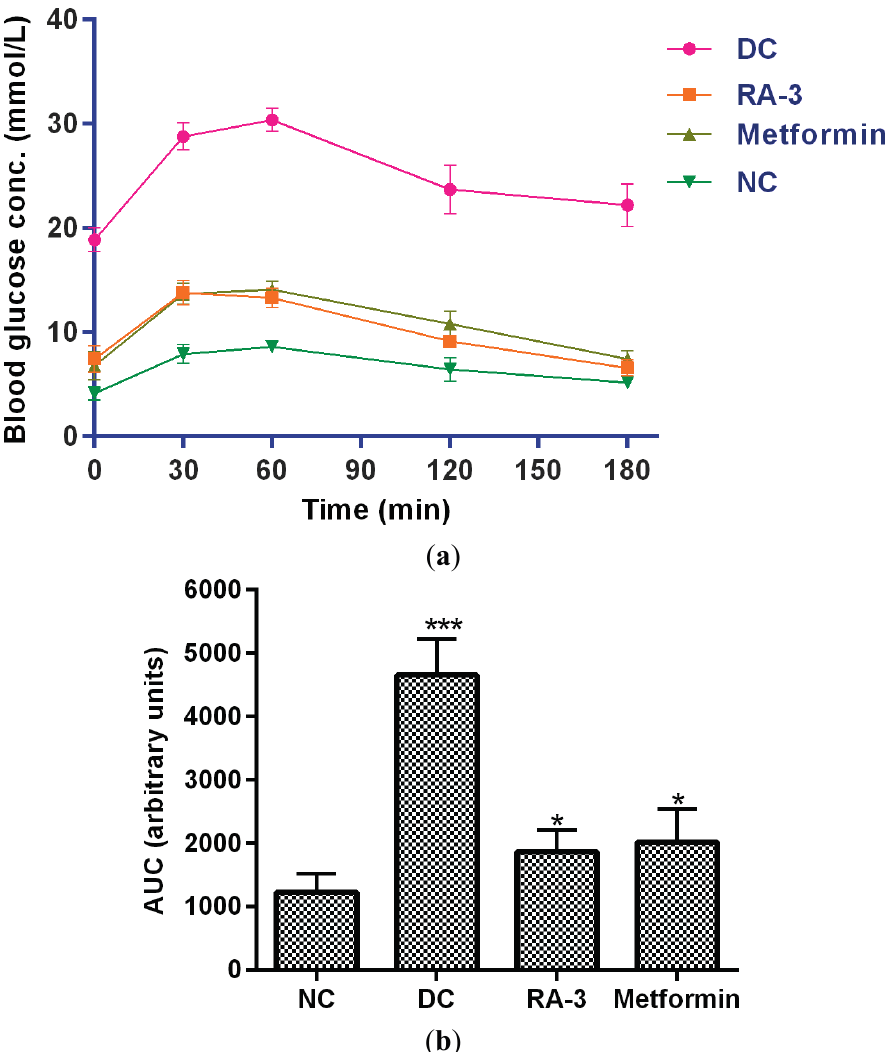
Figure 2. ( a ) Effect of RA-3 on glucose tolerance in diabetic rats. The overnight fasted rats were orally given a glucose load (2 kg/kg b.w). Changes in blood glucose levels were monitored at 0, 30, 60, 90, 120 and 180 min. Data were expressed as mean ± SEM, ( n = 5); NC = Non-diabetic control, DC = Diabetic control, RA-3 = Diabetic + RA-3 , Metformin = Diabetic + metformin; ( b ) AUCs of glucose tolerance test in rats after 14 days treatment with RA-3 and metformin. Data were expressed as mean ± SEM, ( n = 5); * p < 0.05, *** p < 0.001 vs.